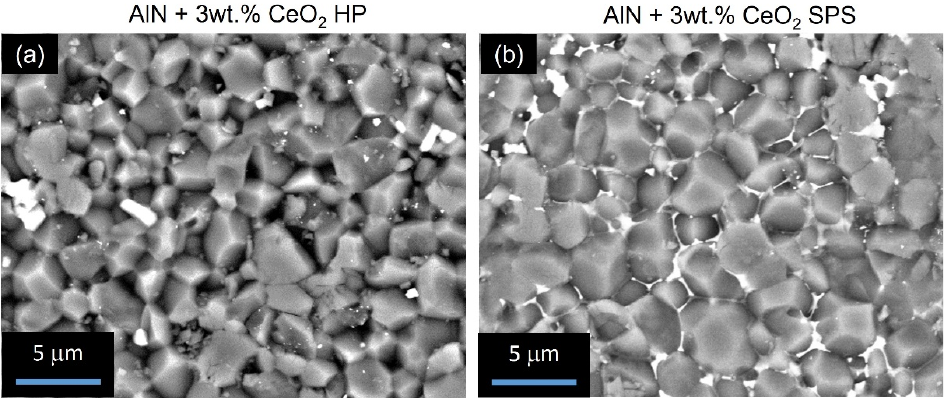
Figure 8. BSD-SEM observations of fractured surface of samples composed of 3 wt.% of cerium oxide ( a ) sintered by HP, ( b ) sintered by SPS.